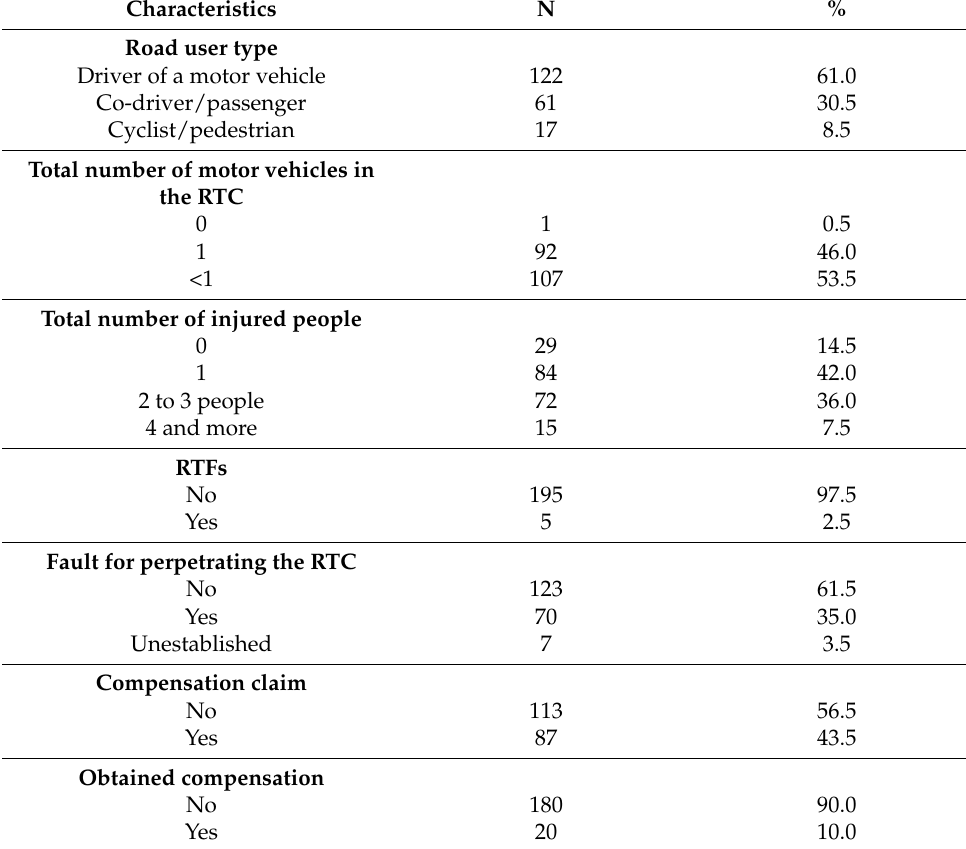
Table 1. RTC details of the